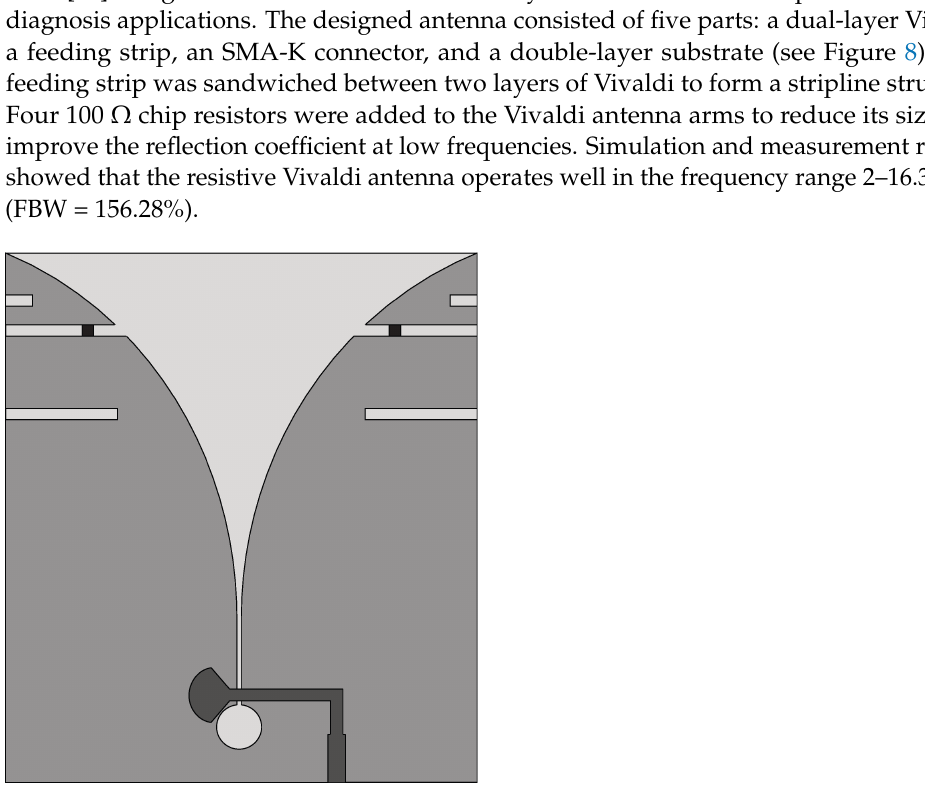
Figure 8. Front view of the resistance-loaded dual-layer Vivaldi antenna (redrawn from [57]). Dark gray top metal face, medium gray bottom metal face, black resistance, and light gray dielectric